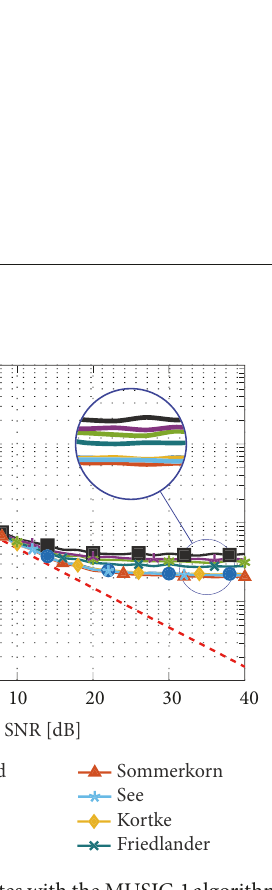
Figure 6: RMSE of AoA estimates with the MUSIC-1 algorithm and calibration w.r.t. the element-space model. The CRLB is plotted as red dashed